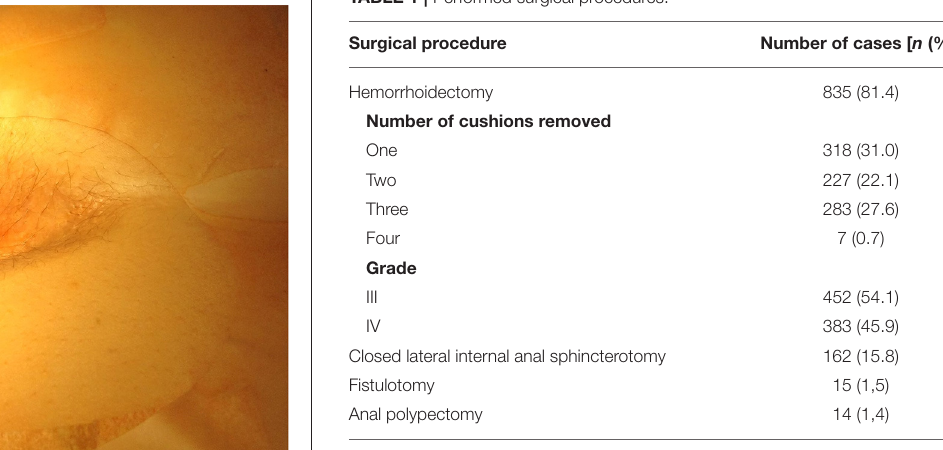
TABLE 1 | Performed surgical procedures.